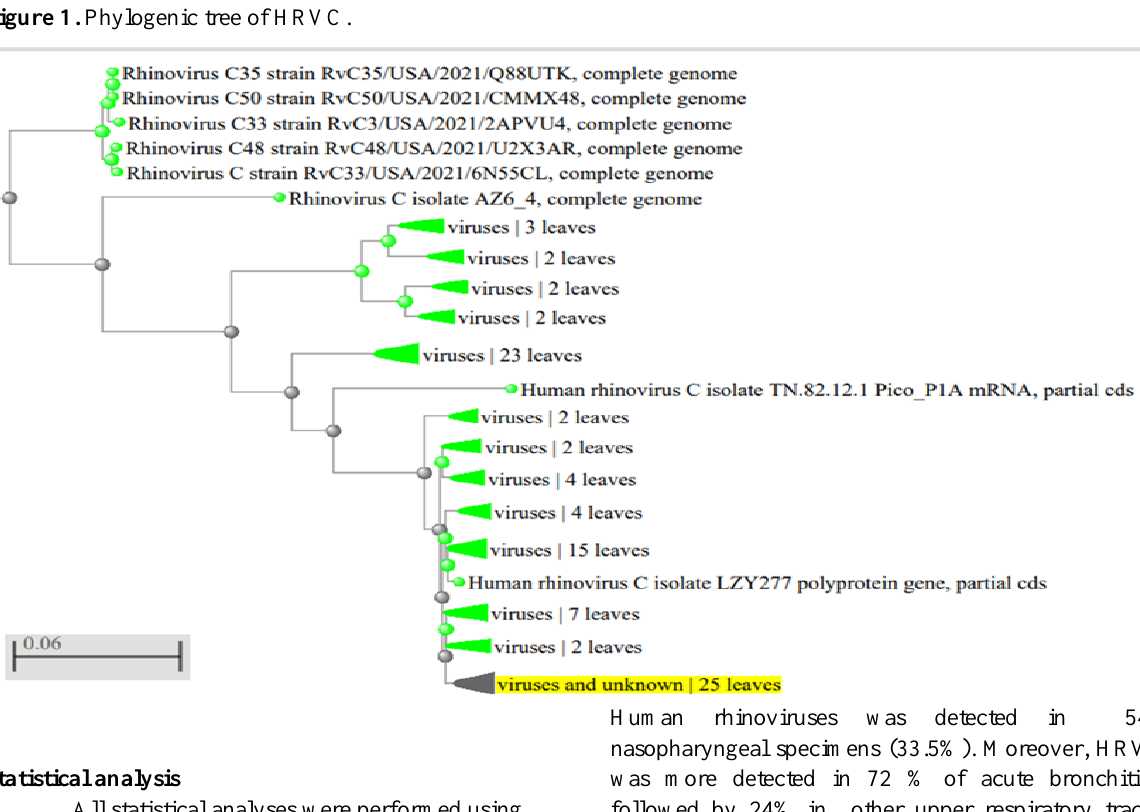
Figure 1. Phylogenic tree of HRVC.